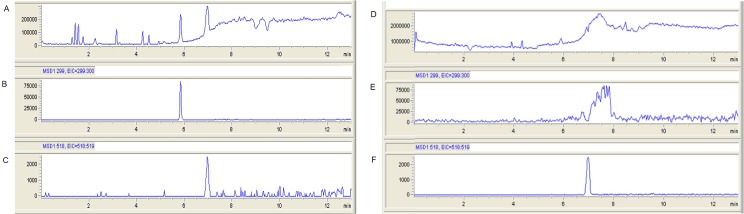
LC/MS analysis of innovator (Wyeth) and generic (Farmalogica) TZP.LC/MS analysis of TZP of innovator (Wyeth, panels A, B and C) and generic (Farmalogica, panels D, E and F) TZP from mouse serum 2 hours after the 640 mg/kg dose. Panels A and D correspond to the complete spectrogram along a 13-minute run, Panels B and E to the specific spectrogram of tazobactam (299:300 Da) and Panels C and F to the specific spectrogram of piperacillin (518:519 Da). The spectrum of the tazobactam component differed markedly between Farmalogica (Panel E) and Wyeth (Panel B). In the generic, the tazobactam peak appears unstable because there are compounds with the same molecular mass but different retention times, while in the innovator the tazobactam peak is neatly defined. It suggests product isomer heterogeneity in the tazobactam component of the Farmalogica product.